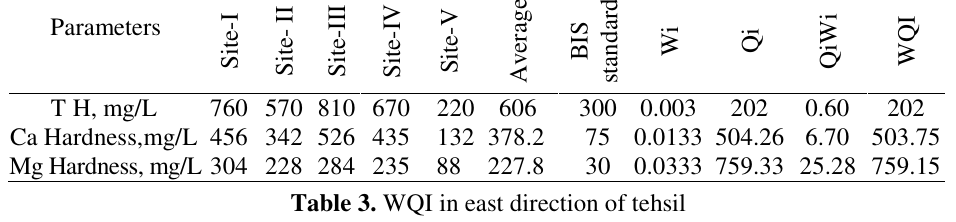
Table 3. WQI in east direction of tehsil